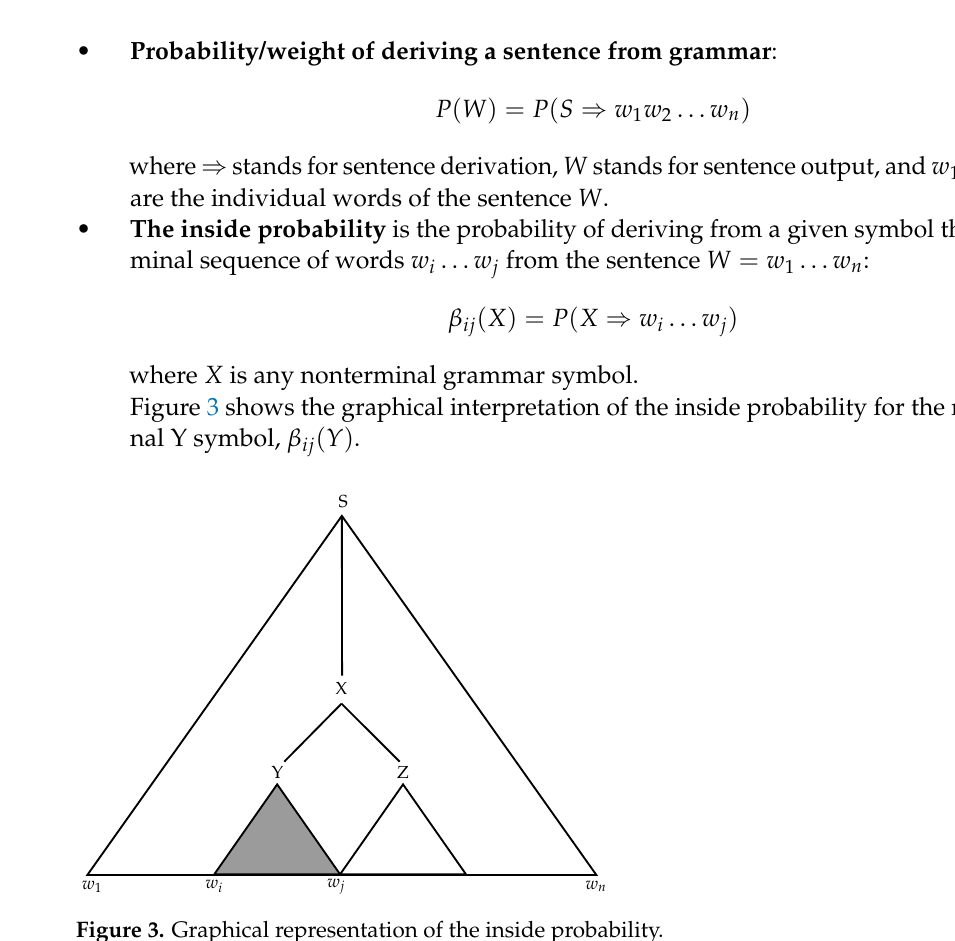
Figure 3. Graphical representation of the inside probability.